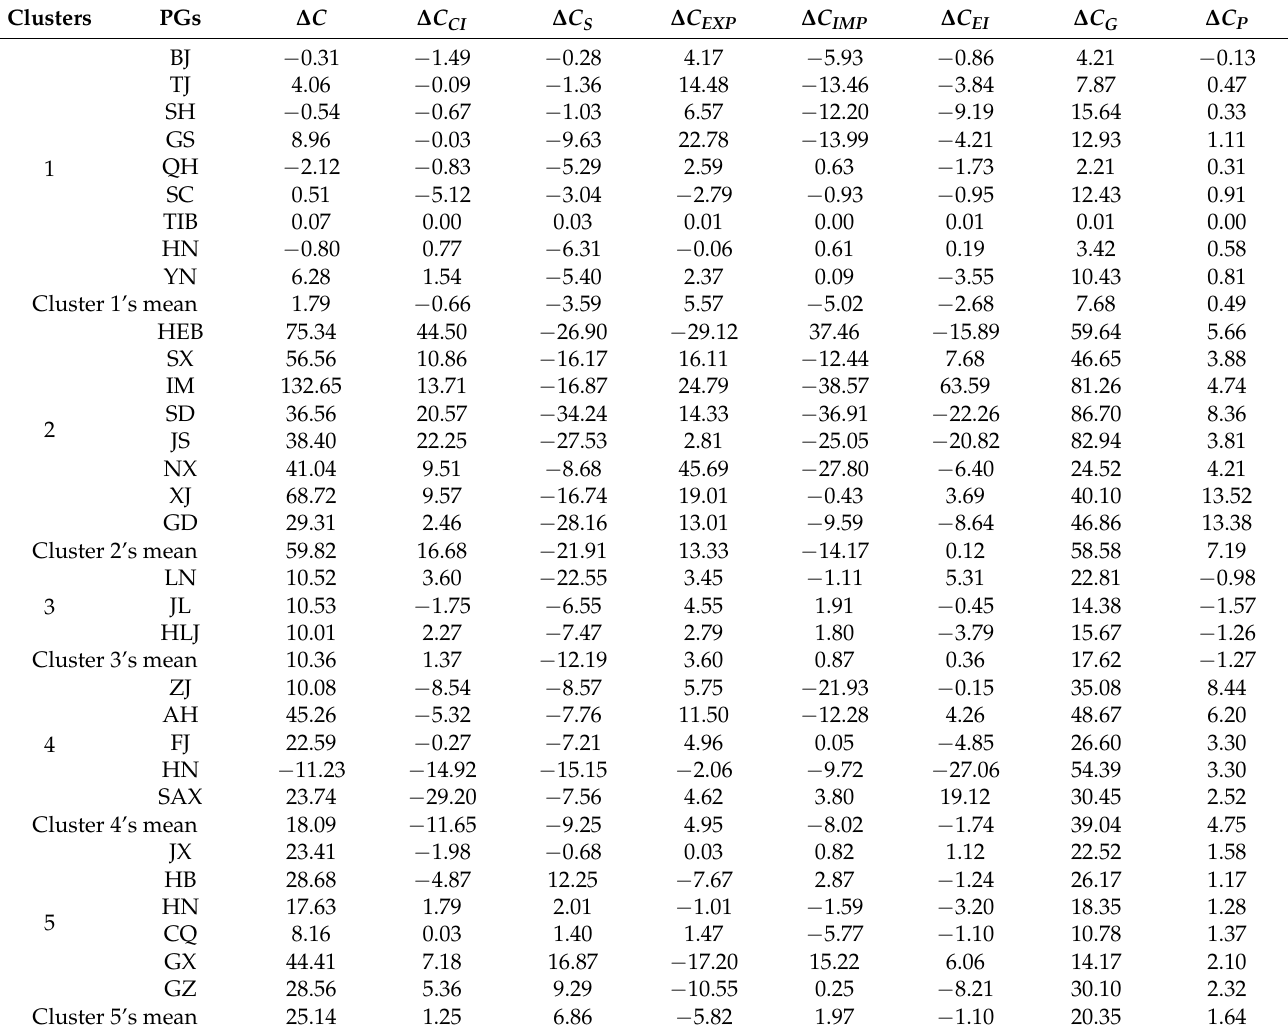
Table 2. Clustering factors and results of random forest clustering during 2015–2019